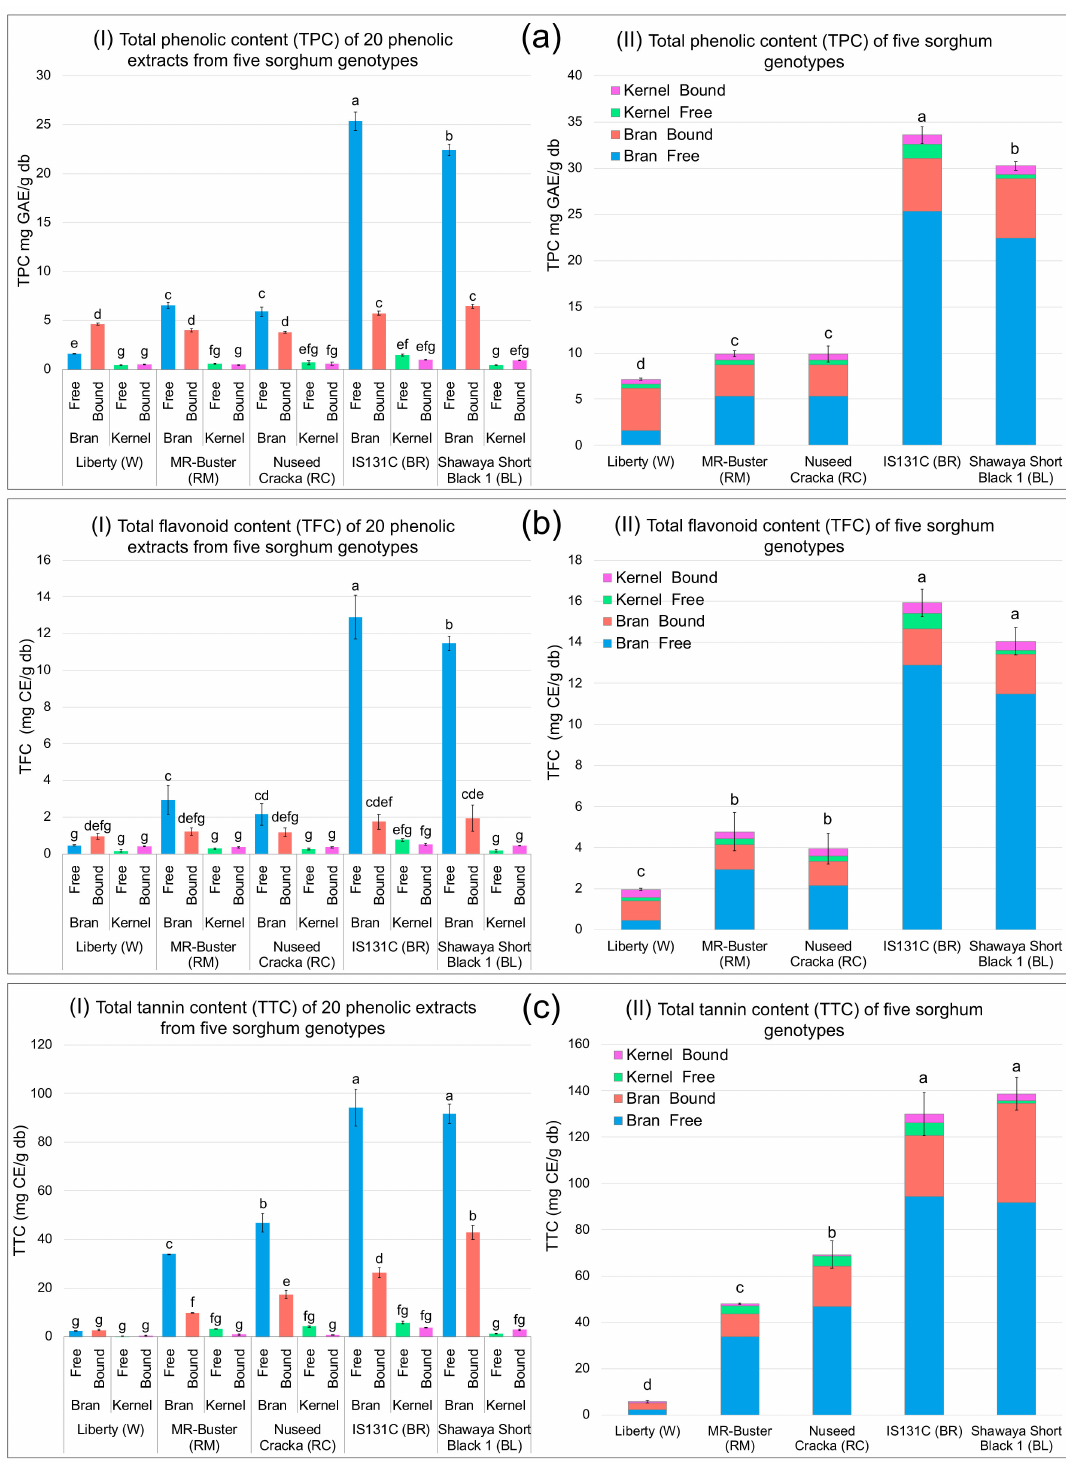
Figure 1. Total phenolic content, total flavonoid content and total tannin content of 20 sorghum phenolic extracts ( a -I, b -I and c -I, respectively) and of five sorghum genotypes ( a -II, b -II and c -II, respectively). Error bars indicate ± standard deviation ( n = 3). Bars with di ff erent small letters are significantly di ff erent ( p <